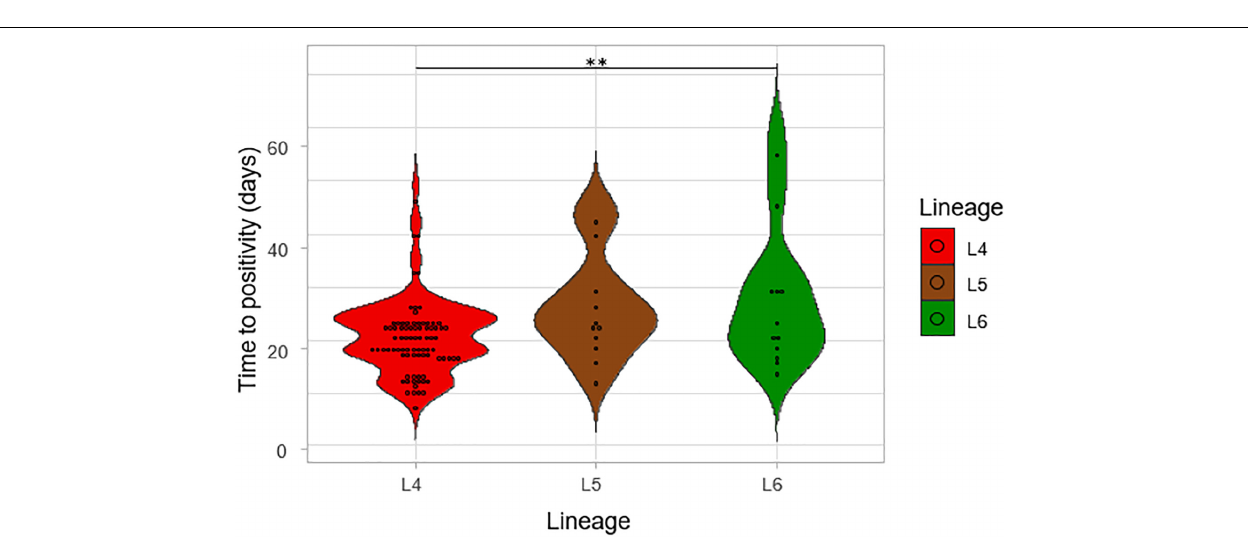
FIGURE 6 | The time to positivity (TTP) on L-J media slants for the lineages. The number of days for the first distinct colony to appear on the media slant was recorded as the time to positivity for the